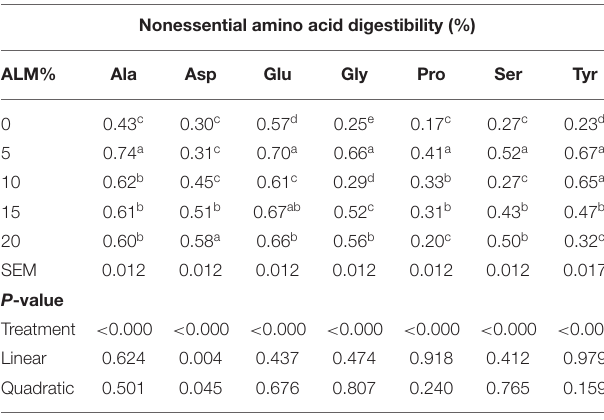
TABLE 8 | Effect of amaranth leaf meal inclusion level on nonessential amino acids digestibility (%) of Ross 308 broiler chickens.